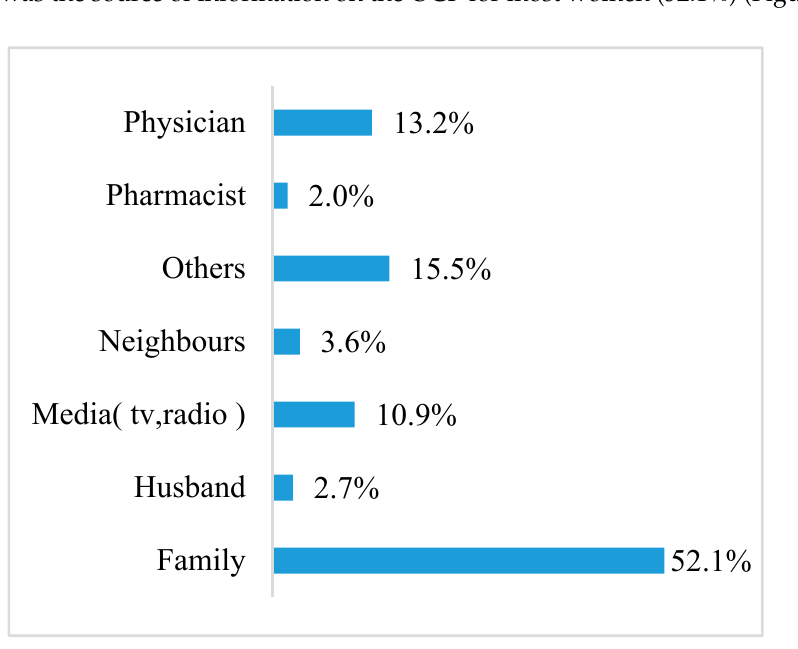
Figure 1. Source of information about OCP.